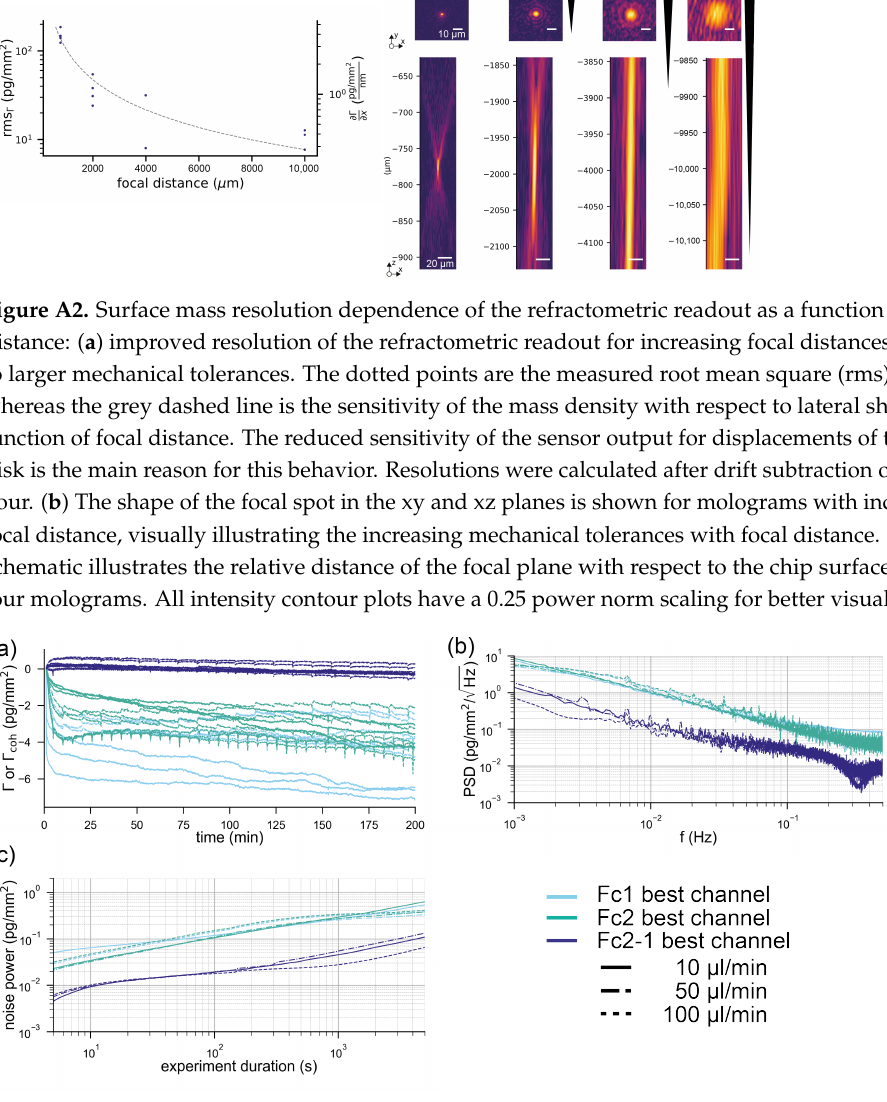
Figure A3. The effect of flow cell referencing in refractometric measurements: ( a ) the binding traces of flow cell 1 (Fc1) and flow cell 2 (Fc2) as well as the difference between the two flow cells (Fc2-1) for three different flow rates in triplicates is shown. In a Biacore 8k+, each of the eight channels has two flow cells operated in parallel and the referencing between two flow cells is considered crucial in high-performance measurements. ( b ) Average power spectral density of the surface mass density noise computed from triplicates of the individual flow cells as well as the referenced trace is shown. All binding traces were prefiltered with a moving average filter of order 3. Referencing reduces the surface mass noise by roughly one order of magnitude. ( c ) Integrated averaged power spectral density of the surface mass density computed by trapezoidal integration from triplicates and plotted for different experiment